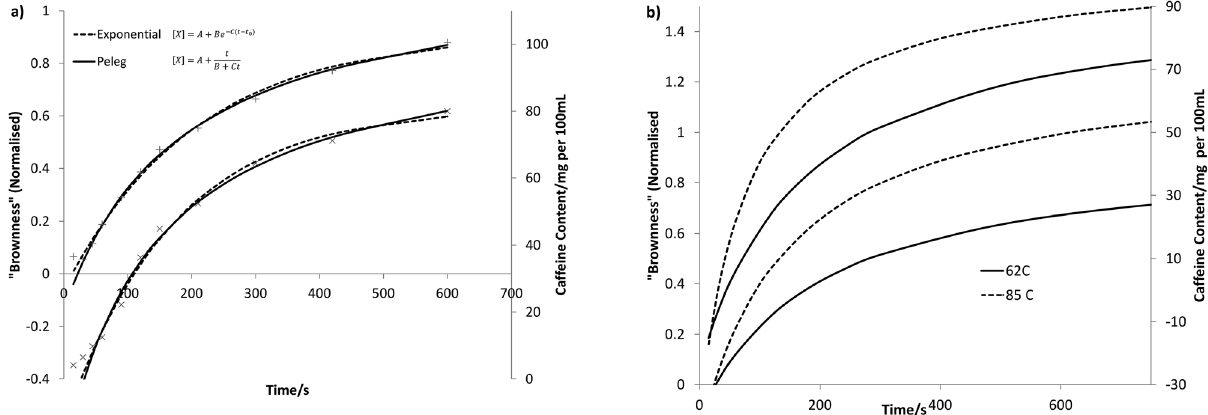
Figure 2: ( a ) Fitted curves of “ brownness ” ( top curves ) and ca ff eine concentration ( lower curves ) against time in tea extracts brewed at 77°C. Both fi ts appear reasonable within the accuracy of the data, but the Peleg fi ts are closer to the data points and these are used for later analysis. ( b ) Fits of curves for normalised brownness ( lower curves left axis ) and ca ff eine ( upper curves right axis ) showing the di ff erent curve shapes and